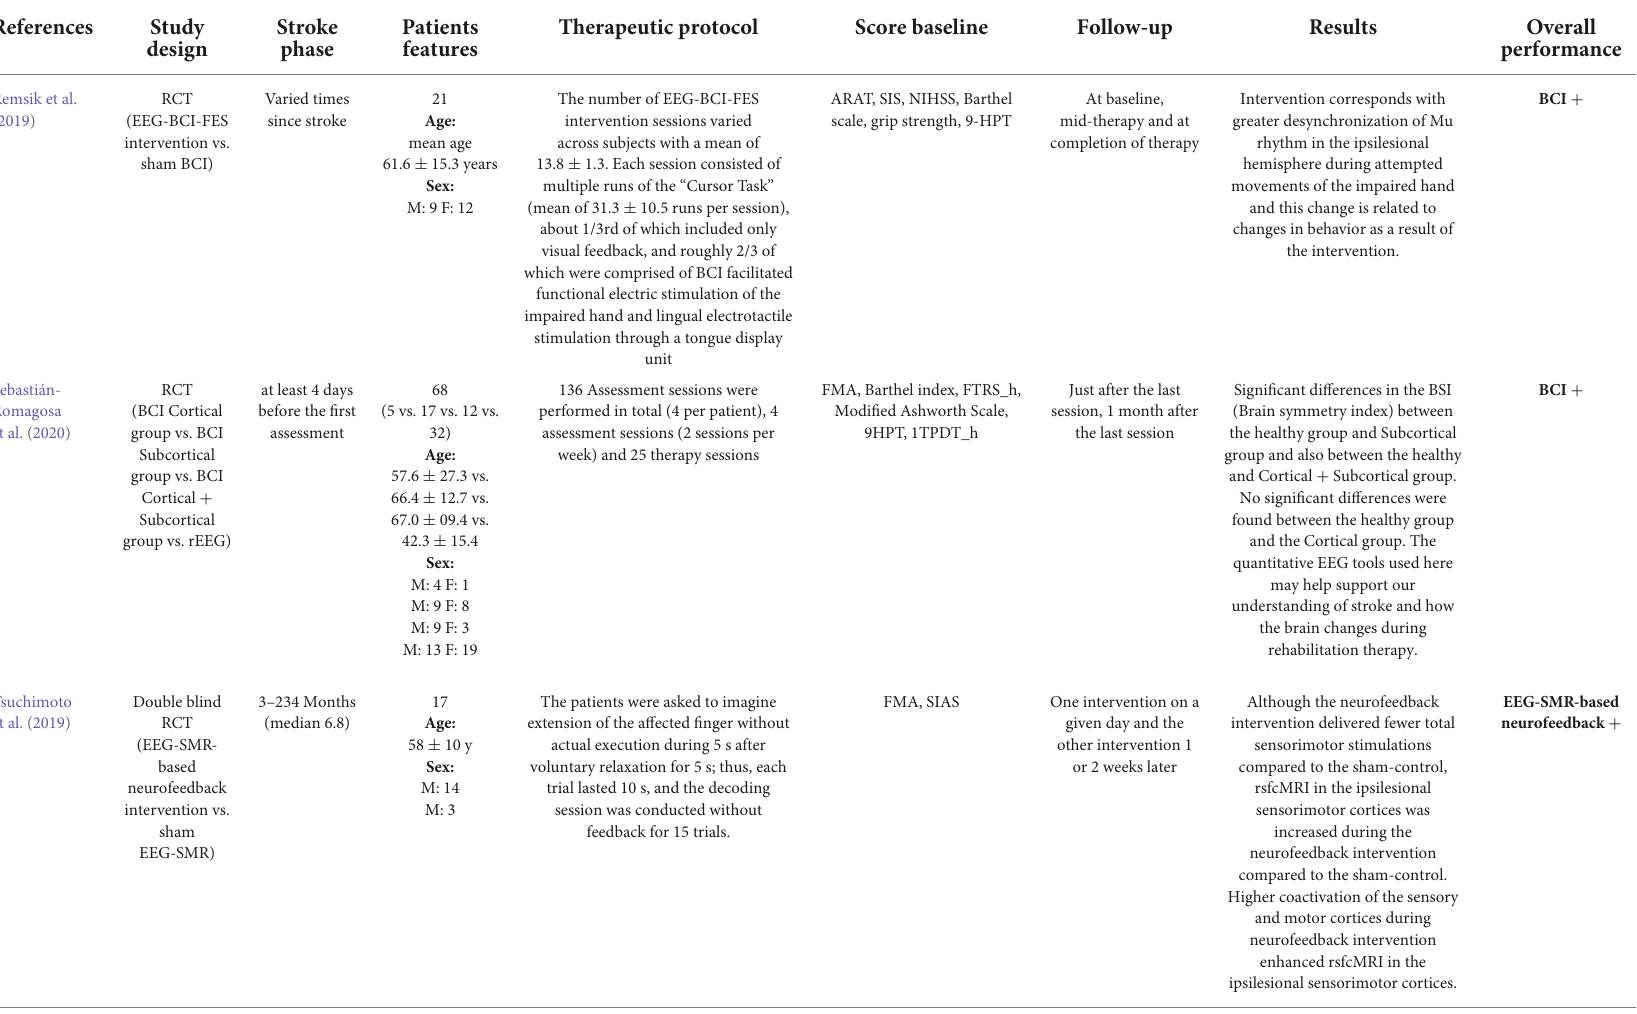
The number of EEG-BCI-FES intervention sessions varied across subjects with a mean of 13.8 ± 1.3. Each session consisted of multiple runs of the “Cursor Task” (mean of 31.3 ± 10.5 runs per session), about 1/3rd of which included only visual feedback, and roughly 2/3 of whichwerecomprisedofBCIfacilitated functional electric stimulation of the impaired hand and lingual electrotactile stimulation through a tongue display